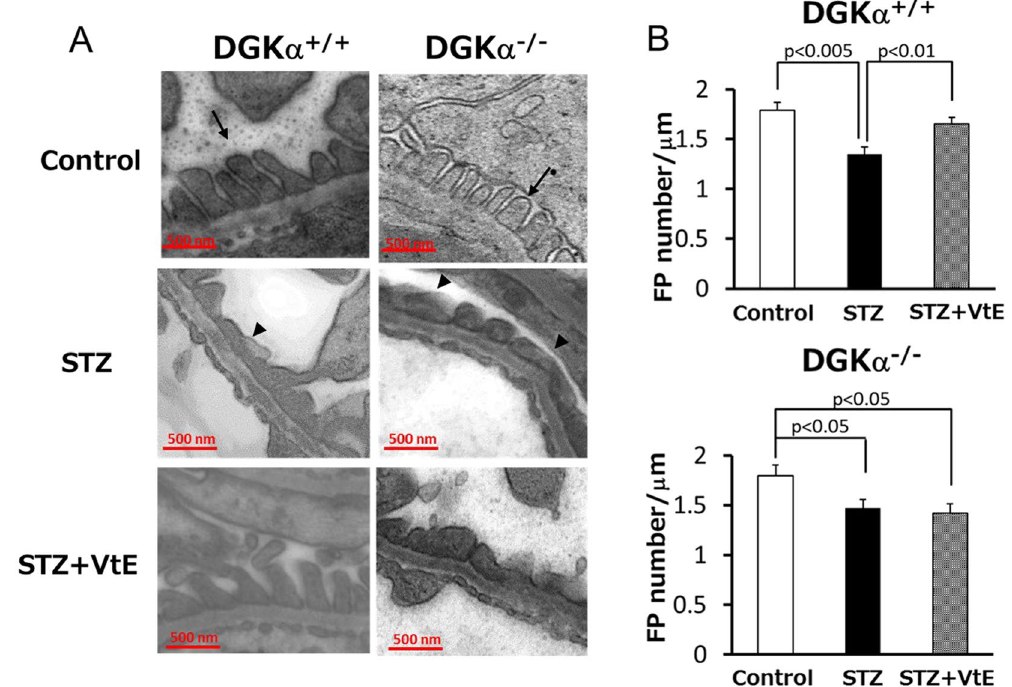
Figure 3. Transmission electron microscopy of podocyte morphology. ( A ) Transmission electron microscopy (TEM) images of glomeruli from mice at 6 weeks after STZ administration. The arrow points to a normal FP, and the arrowhead points to a broadened FP. ( B ) The number of FPs in the TEM images was counted, and the number was normalized to the GBM